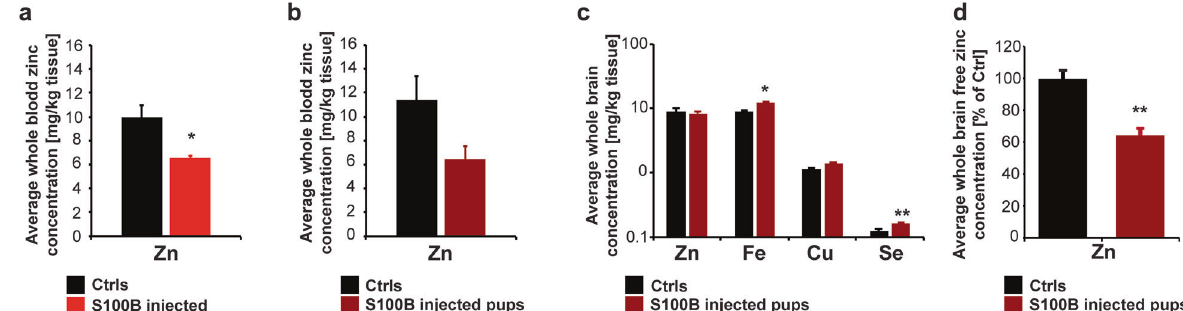
Fig. 3 S100B injection alters zinc levels in vivo. a – c Measurement of trace element levels in whole blood and brain tissue of mice using ICP- MS. a The average whole blood concentration of Zn is signi fi cantly different between saline- and S100B-injected pregnant mice ( t -test, p = 0.0335; n = 3 per group). b The average whole blood concentration of Zn is not signi fi cantly different between pups from Ctrls ( n = 7), and S100B-injected mice ( n = 4). c The average concentration of Zn and Cu in whole-brain tissue is not signi fi cantly different between pups from Ctrls ( n = 10) and S100B-injected mice ( n = 7). Fe and Se levels are signi fi cantly increased in pups from S100B-injected mice ( t -test, p Fe = 0.0356; p Se = 0.0084). d The average free Zn concentration measured by Zinpyr1 fl uorescence assays shows signi fi cantly lower free Zn levels in the brain of pups from mothers with S100B injection compared to Ctrls ( n = 3 per group) ( t -test, p =